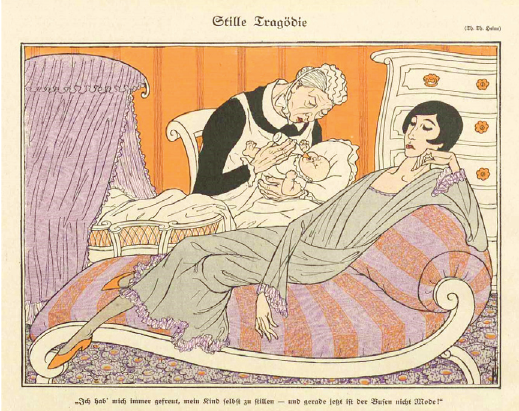
Figure 21. ‘Quiet Tragedy’, Simplicissimus , 30 (1925), 440. ‘I always looked forward to breast-feeding my child - but now busts are out of fashion.’ Image courtesy of Herzogin Anna Amalia Bibliothek, Weimar, © DACS 2014.